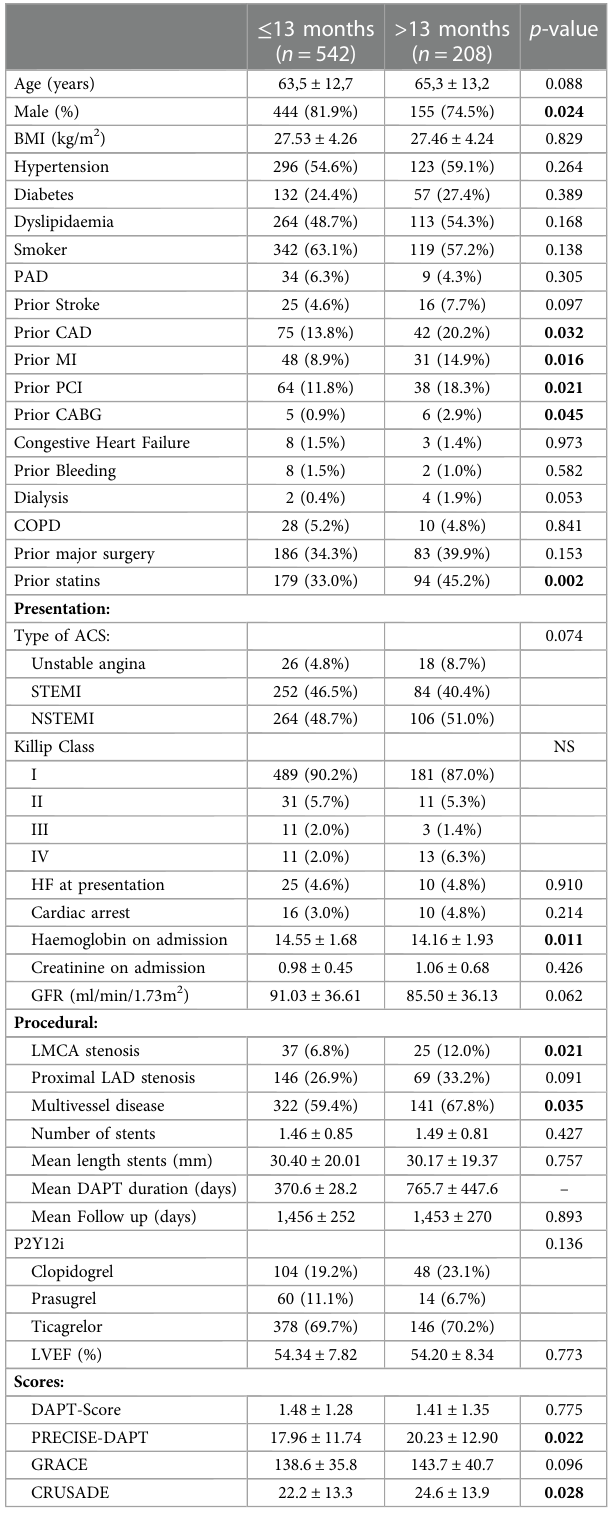
BMI, body mass index; PAD, peripheral artery disease; CAD, coronary artery disease; MI, myocardial infarction; PCI, percutaneous coronary intervention; CABG, coronary artery bypass graft; CHF, congestive heart failure; COPD, chronic obstructive pulmonary disease; STEMI, ST-elevation myocardial infarction; NSTEMI, non-ST elevation myocardial infarction; HF, heart failure; GFR, glomerular fi ltration rate; LMCA, left main coronary artery; LAD, left anterior descending artery; DAPT, dual antiplatelet therapy; LVEF, left ventricular ejection fraction. Bold values are statistically signi fi cant values.